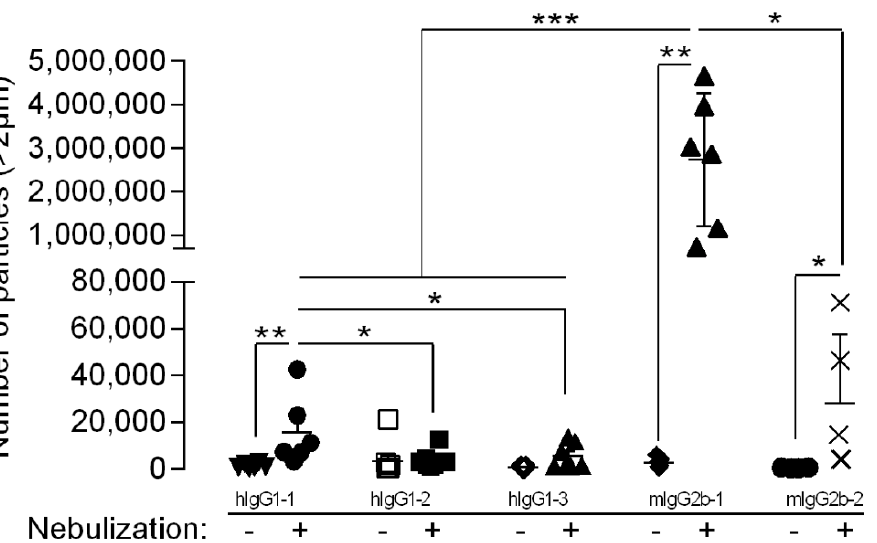
Figure 1. Antibodies were either nebulized using an Aeroneb Pro TM vibrating-mesh nebulizer and collected (Nebulization +) or left untreated (Nebulization − ). The total number of particles (with diameter >2 µ m) was quantified using a flow microscope. The data are quoted as the mean ± SEM. *, **, ***: p < 0.05, p < 0.01 and p < 0.001, respectively, in a one-way ANOVA with Newman–Keuls correction for multiple comparisons. The results represent three to eight independent nebulizations.